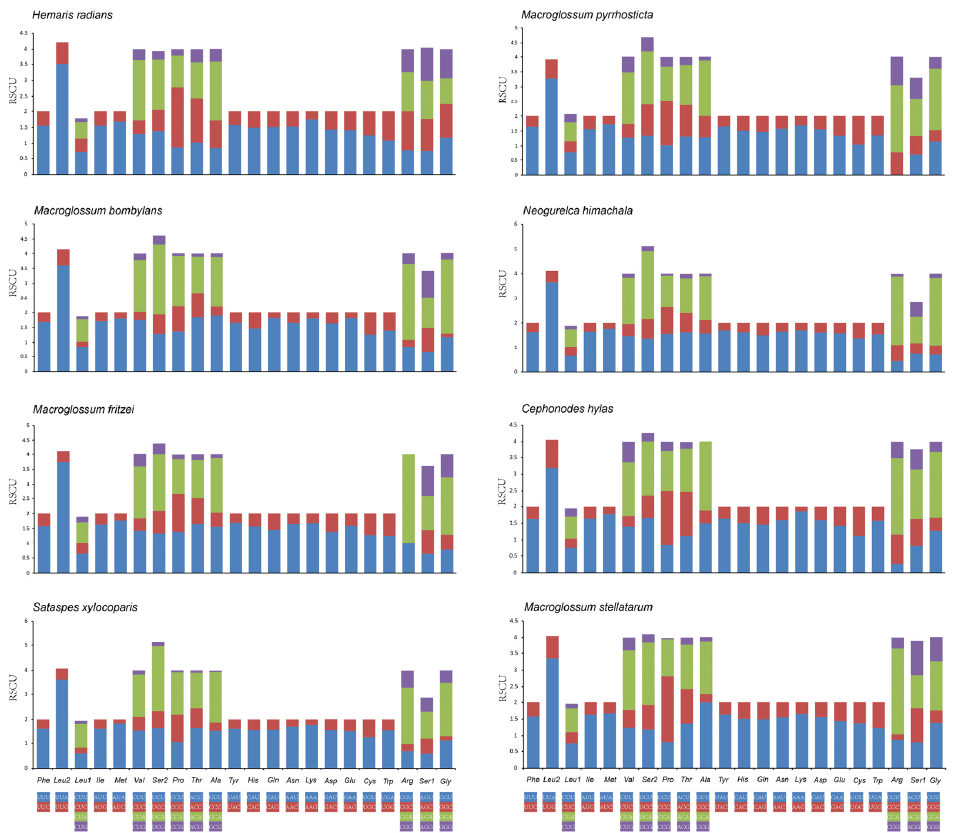
Figure 2. Relative synonymous codon usage (RSCU) of the mitochondrial genomes of eight diurnal hawkmoths. Codon families were provided on the X -axis. The value of the Y -axis indicates relative synonymous codon usage (RSCU).